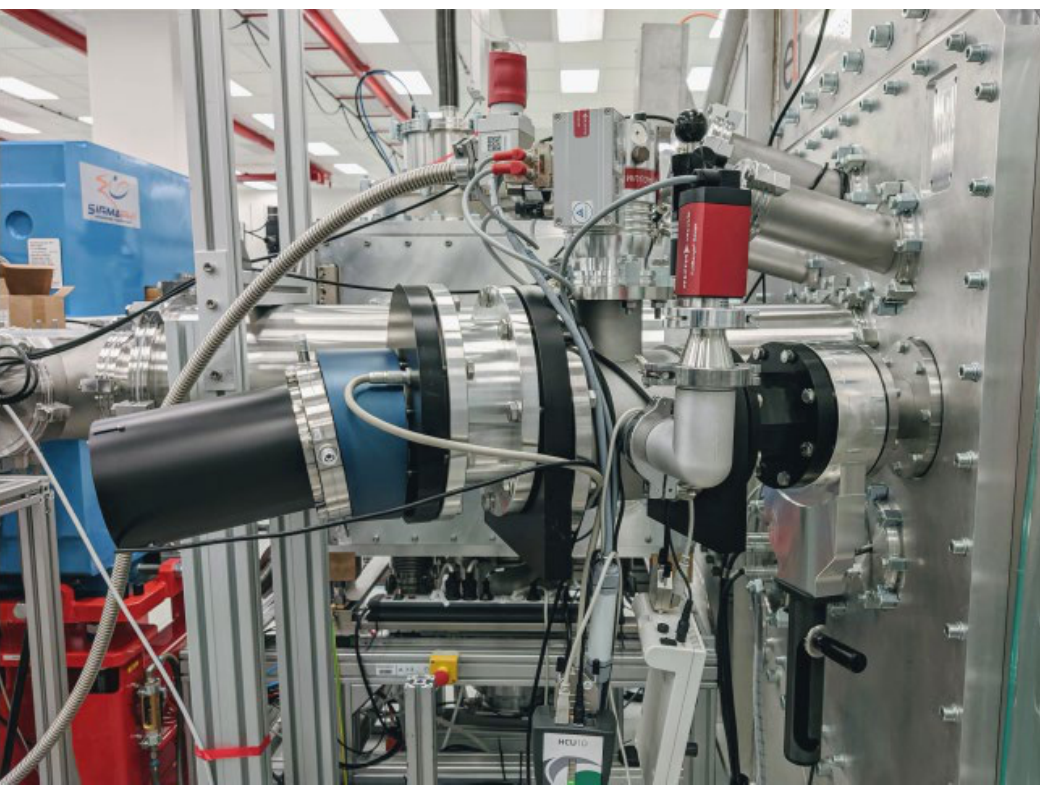
Figure 16. XUV spectrometer installed on the ECU D2 chamber and pointing at the interaction point.